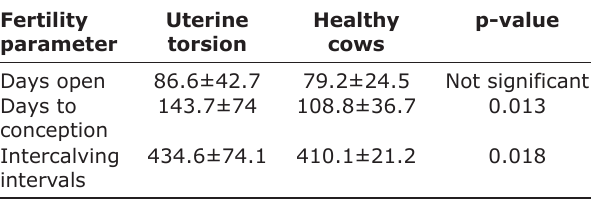
Figure-1: Percentages of dairy cows that showed accelerated, physiological, and delayed expulsion of the fetal Table-1: Fertility parameters in cows with and without uterine torsion. p < 0.5 indicate significant differences between the groups.